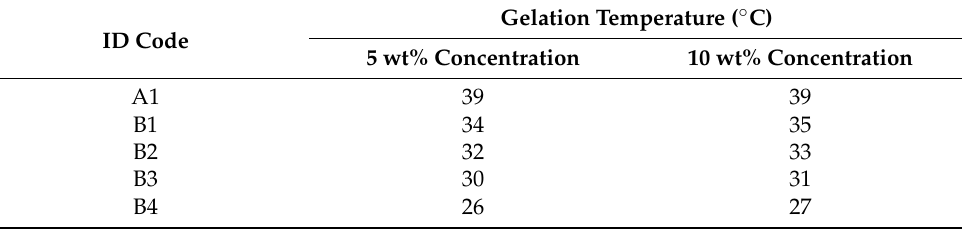
Figure 7. UV Spectrometry illustrating the LCST of the 5 wt% polymer solutions for PNVCL/VAc and PNVCL/NVP samples. ( (cid:4) ) PNVCL100, ( (cid:78) ) PNVCL90-NVP10, ( (cid:4) ) PNVCL90-VAc10, ( (cid:78) ) PNVCL80-VAc20, ( (cid:72) ) PNVCL70-VAc30, and ( )PNVCL60 ‐ VAc40. Table 6. The gelation ( ◦ C) results of the PNVCL, PNVCL/Vac, and PNVCL/NVP aqueous polymer